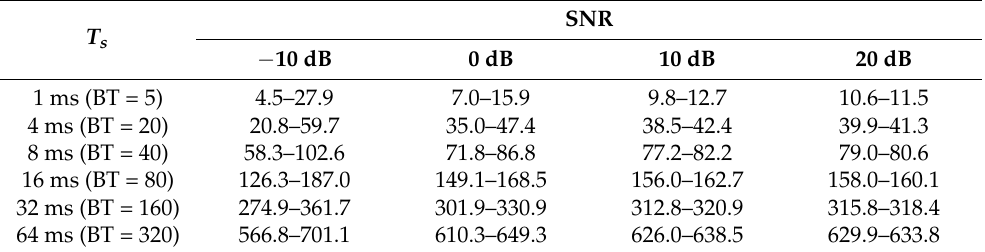
Table 1. Ranges of maximum values of the correlation function for different values of T PS and